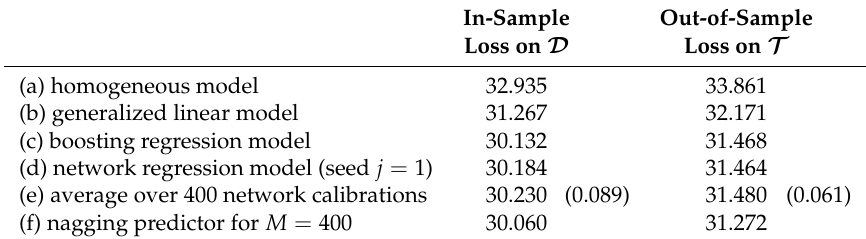
Table 2. (a) Homogeneous model not using any feature information, (b,c) generalized linear model (GLM) and boosting regression models both from Table 11 in Noll et al. (2018), (d) network regression model as outlined above for given seed j = 1, (e) averaged losses over 400 network calibrations (with standard errors in brackets), (f) nagging predictor; losses are in 10 − 2